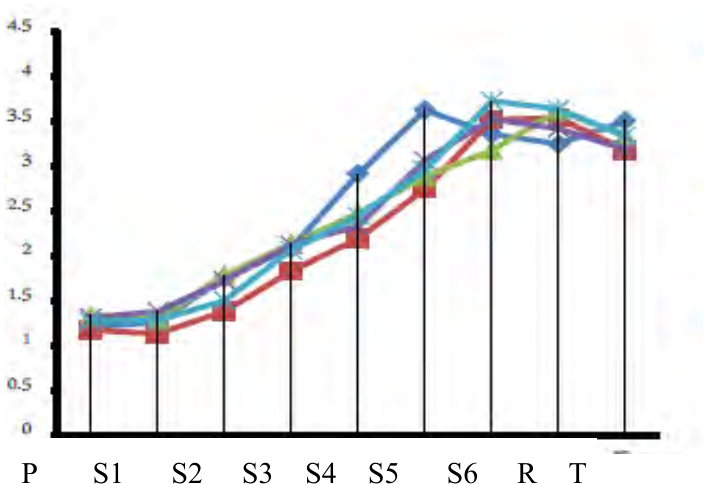
Fig 2. Mean Performance of Treatment Groups in Pretest Session (P), Exercise Sessions (S1-S6) & Retention-Transfer Session (R